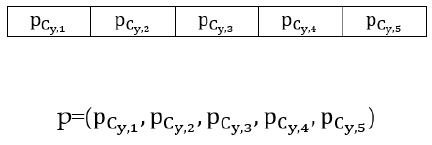
Figure 3. Production of the vector P.